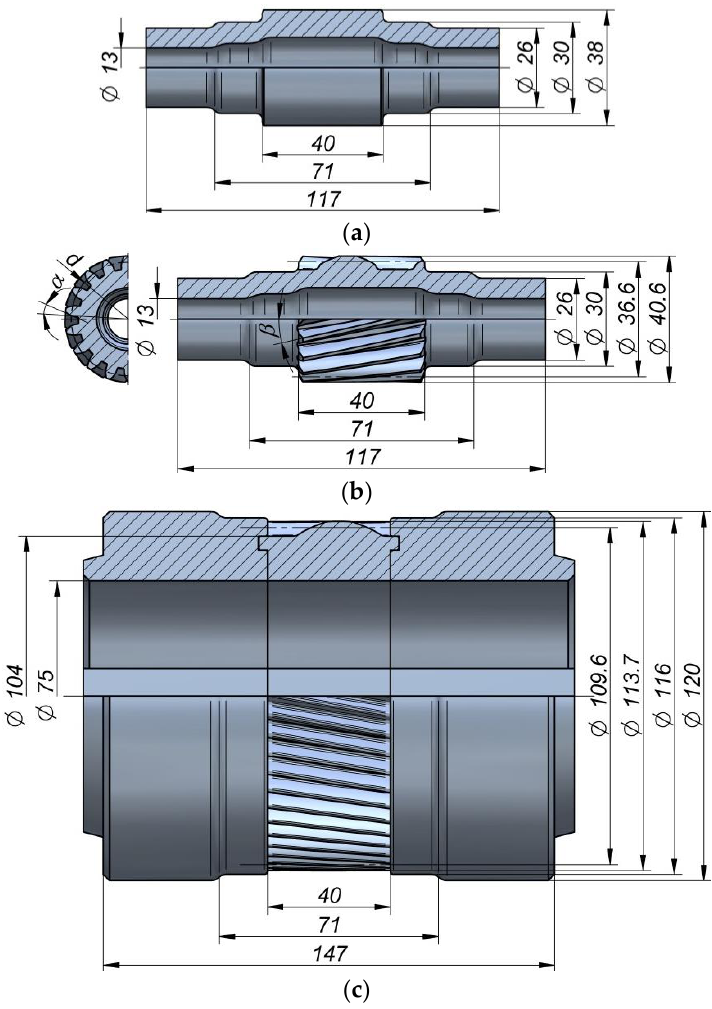
Figure 3. Shape and overall dimensions of: semi-finished product ( a ), product ( b ), tools ( c ), in Operation 2.